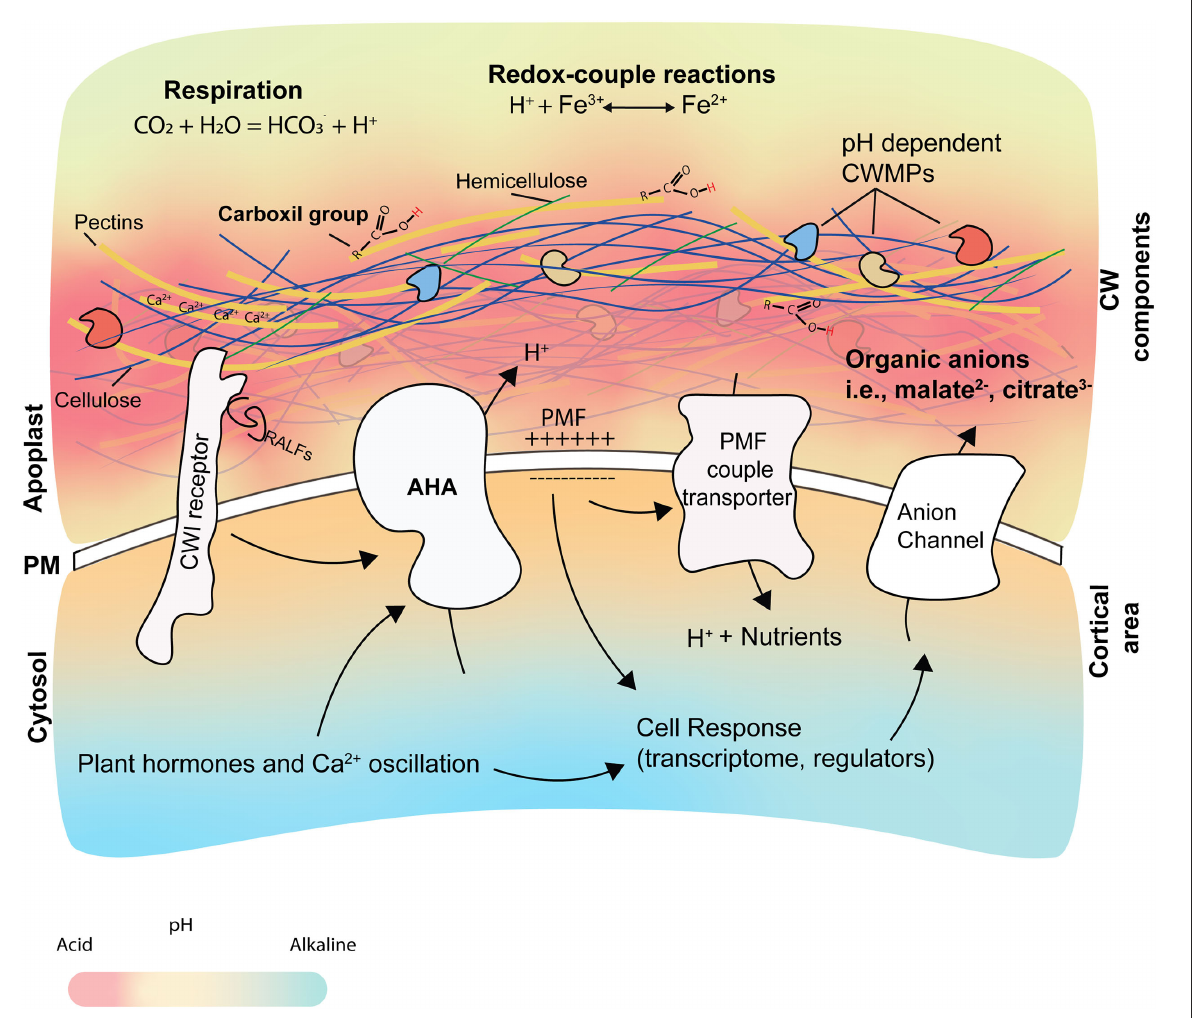
FIGURE2 Origin and consequences of pH apo changes. The root pH apo is determined by different cellular elements and processes, such as root respiration, redox-coupled reactions, CW structure, organic acids, and the activity of AHAs. Changes in pH apo affect the activity of CW modifying proteins (CWMPs), water and nutrient uptake, and the cellular response. The pKa is predicted to be more acidic in the CW than the apoplastic fluid. The AHA activity participates in the creation of the proton motive force (PMF), which is used by different transporters to internalize nutrients. Calcium ions (showed as Ca 2 + ) contribute to CW structure by interacting with pectins and forming the egg- box in a pH-dependent manner. AHA activity is regulated by phytohormones and by CW integrity sensors after perceiving signals at the apoplast (like RALFs and DAMPs), leading to apoplast